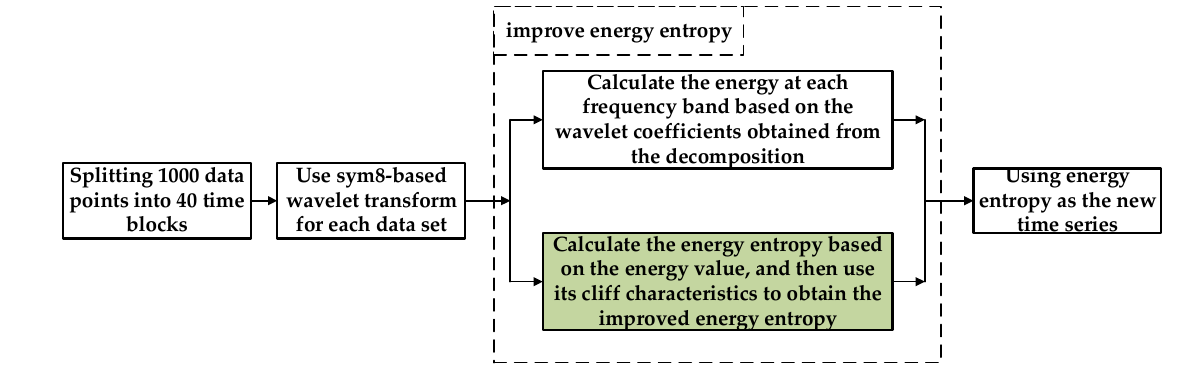
Figure 4. Flow chart of wavelet energy entropy method.